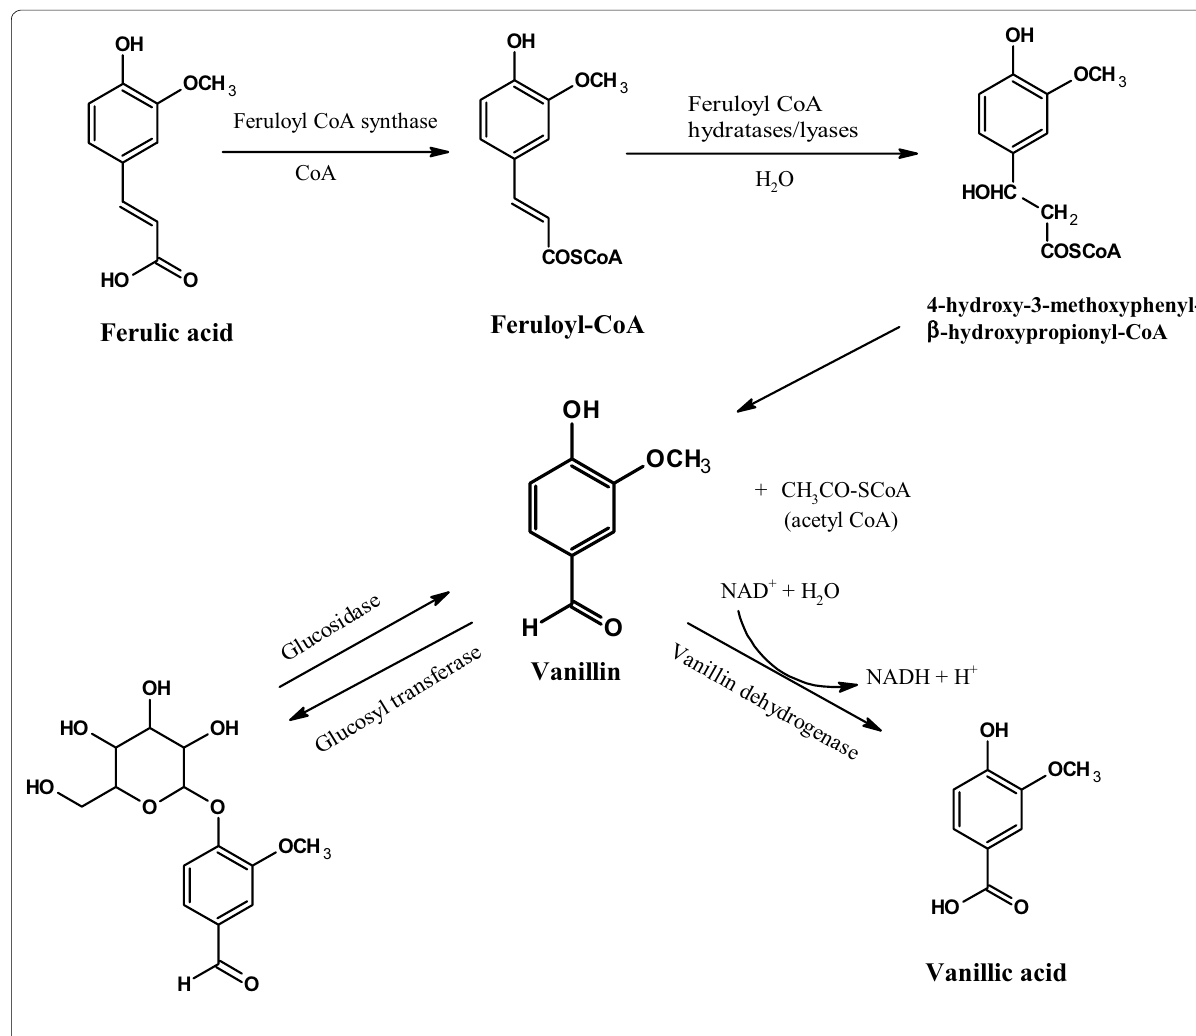
Fig. 5 The proposed vanillin production mechanism through phenolic biotransformation in Aspergillus luchuensis. The side chain cleavage of ferulic acid through feruloyl-CoA and feruloyl-CoA hydratase/lyase give vanillin and acetyl-COA, then the dehydrogenation of vanillin produced vanillic acid. In addition, the glucose dehydrogenation of the vanillin glucoside is produced vanillin through the reversible